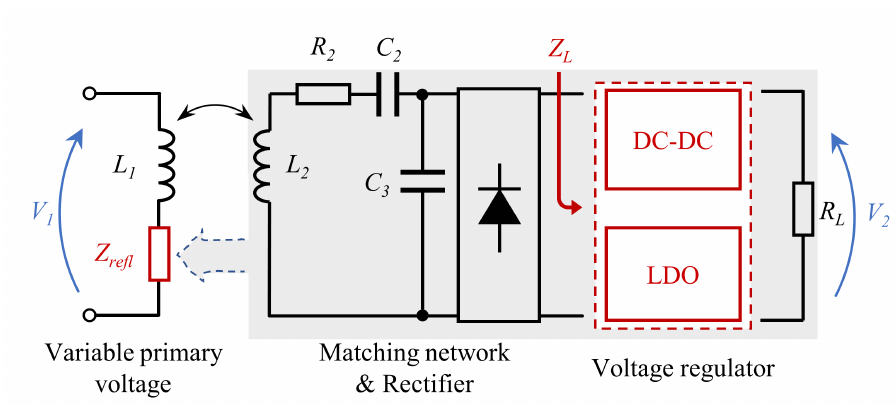
Figure 4. System structure of the secondary side voltage regulator and concept of the reflected impedance in the primary